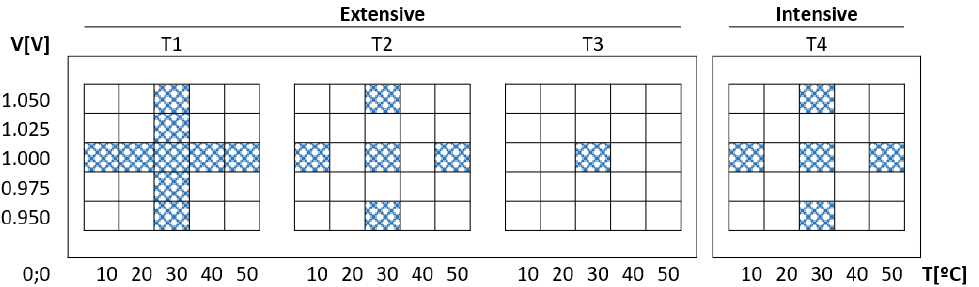
Figure 16. PUF voltage and temperature characterization